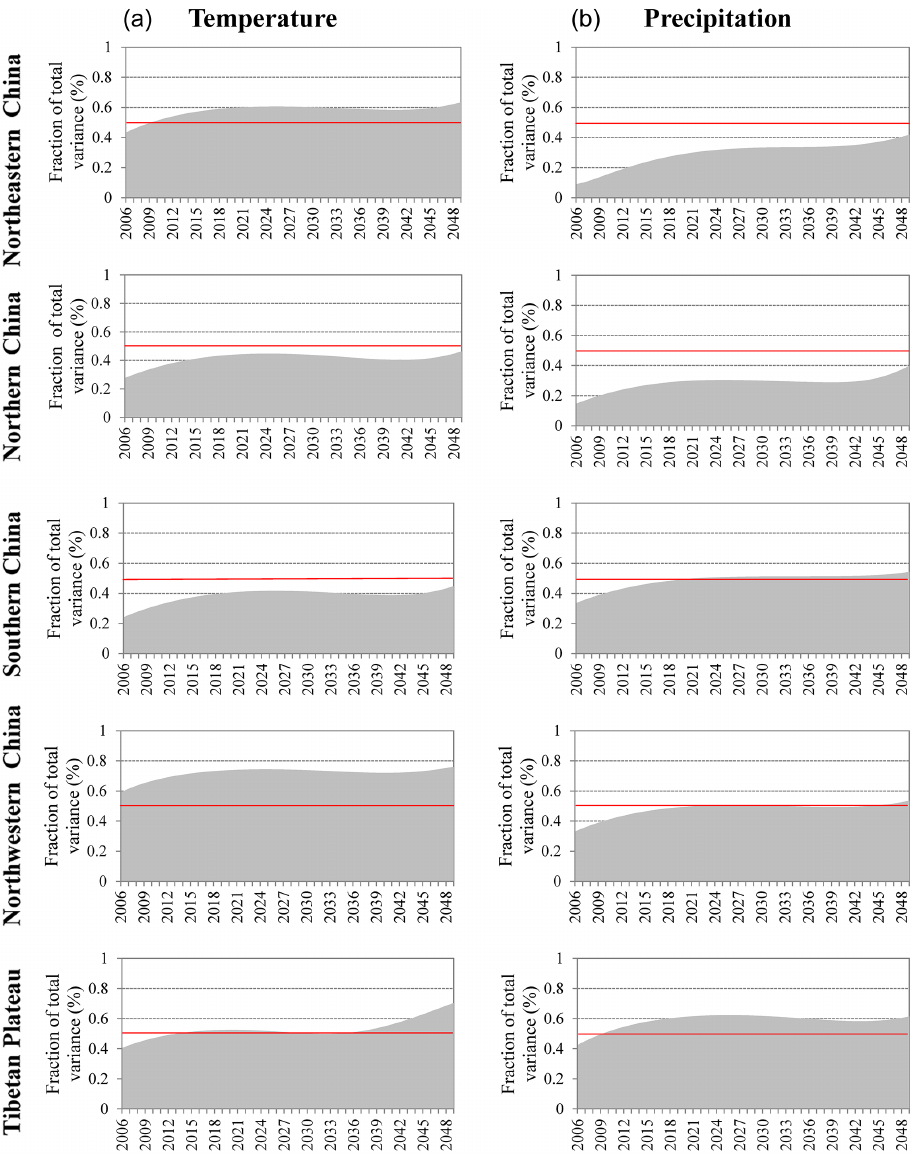
Figure 10. Fraction of total variance in future temperature (a) and precipitation (b) projections explained by inter-model variability (gray) and internal variability (white) over the five